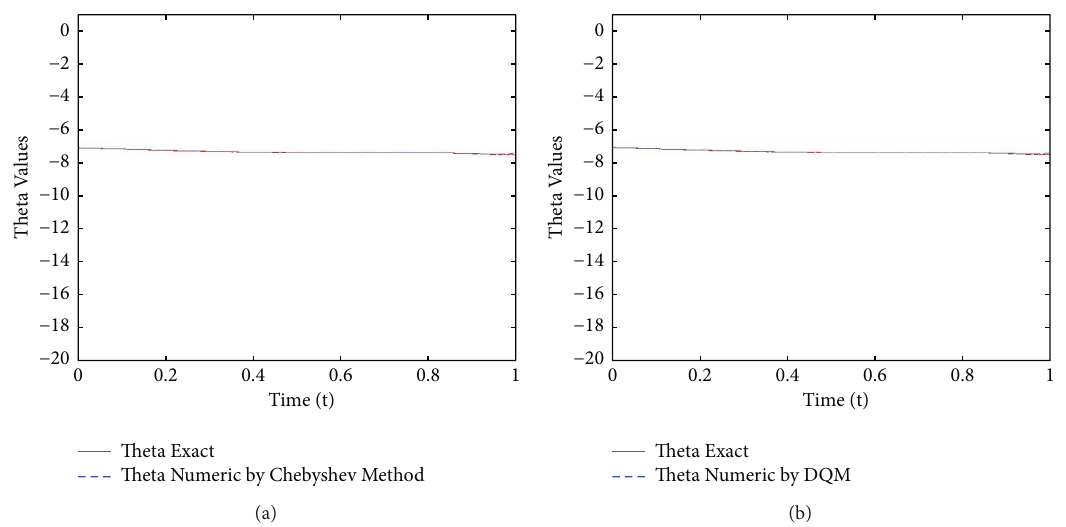
Figure 18: We plot exact and numerical values of theta for S � 99 . 0580. (a) is for the Chebyshev method, and (b) is for the DQM.